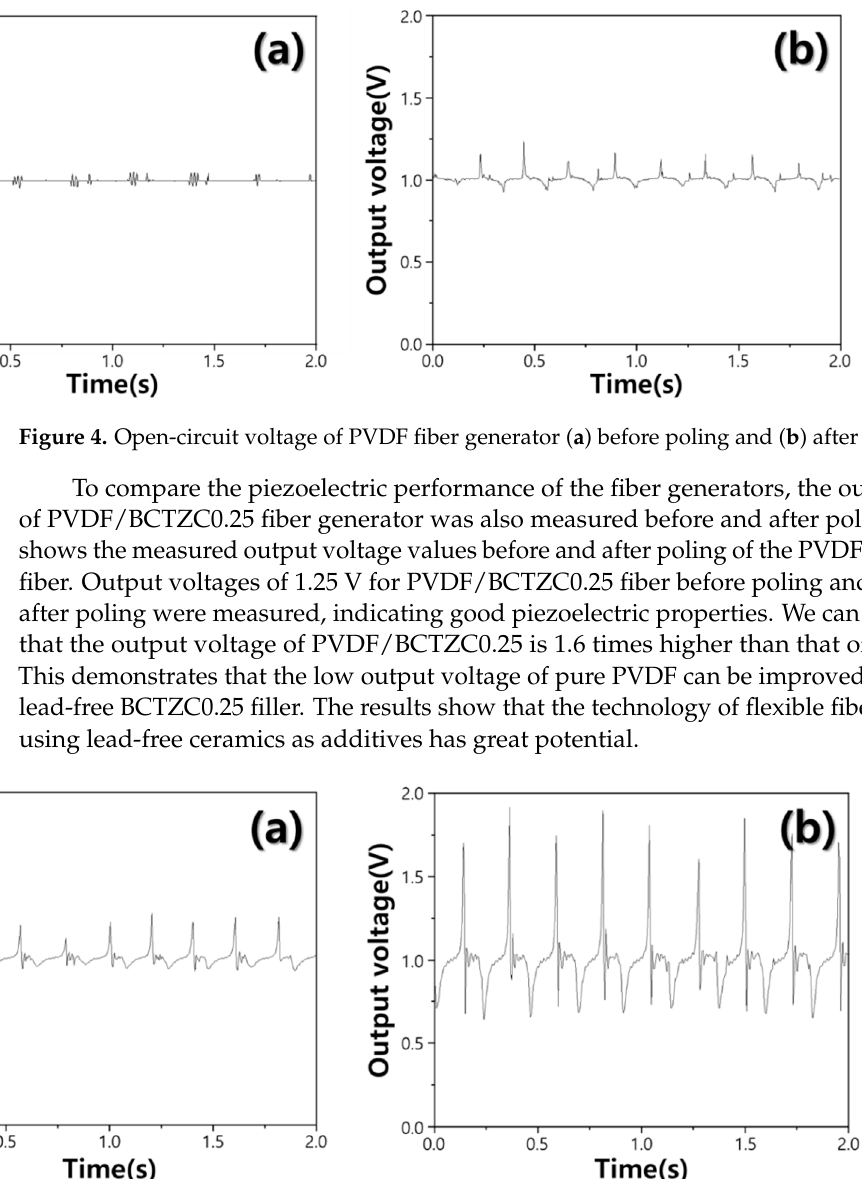
Figure 3. Surface field emission-scanning electron microscope (FE-SEM) images of the ( a ) PVDF